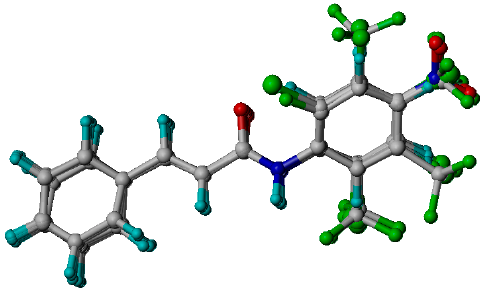
Figure 6. Superimposition of 1 – 20 anilides according to AAA hypothesis.